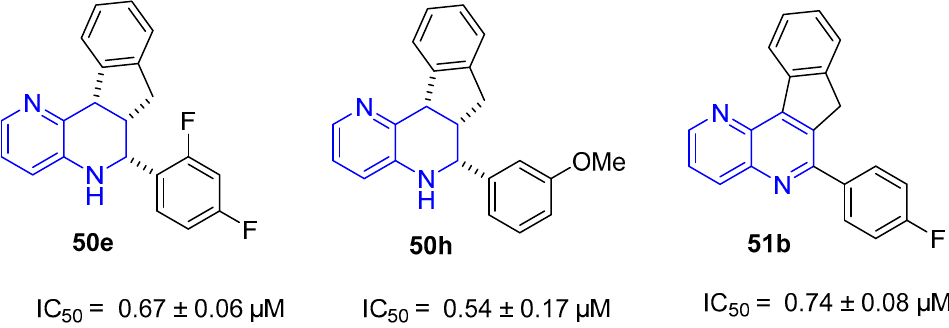
Figure 18. Antileishmanial activity of 50e , 50h , and 51b .